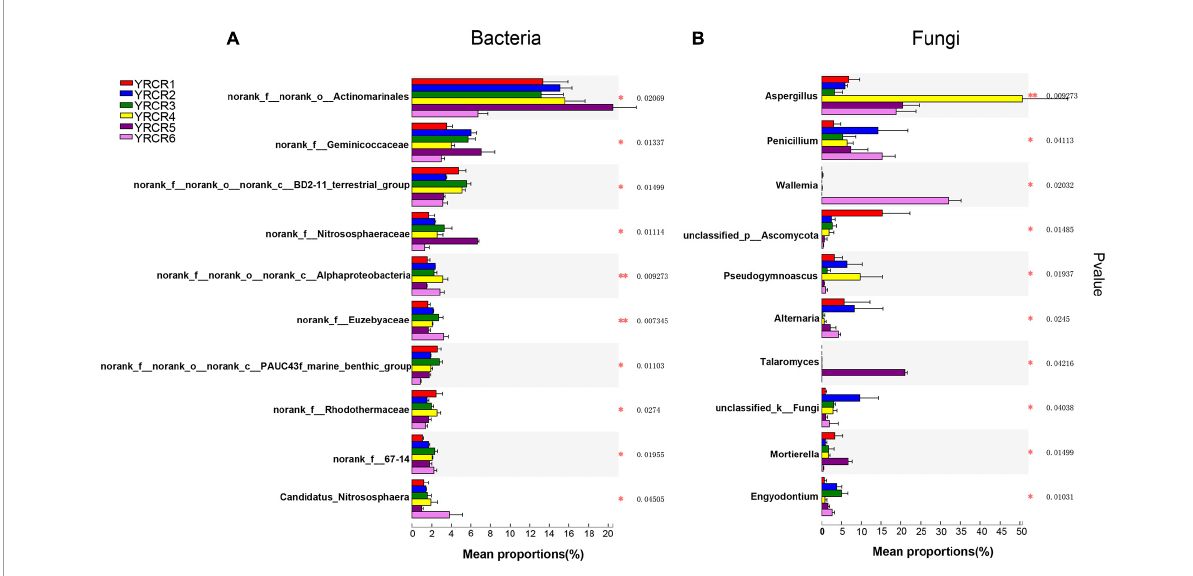
FIGURE3 Species difference analysis of all samples on genus level. The y -axis represents the genus levels of species, and the x -axis represents the percentage of species average relative abundance in each sample group. (A) Is represent bacteria; (B) is represent Fungi. The Kruskal–Wallis rank-sum test was used to show significant differences ( ∗ : 0.01 < P < = 0.05, ∗∗ : 0.001 < P < = 0.01).